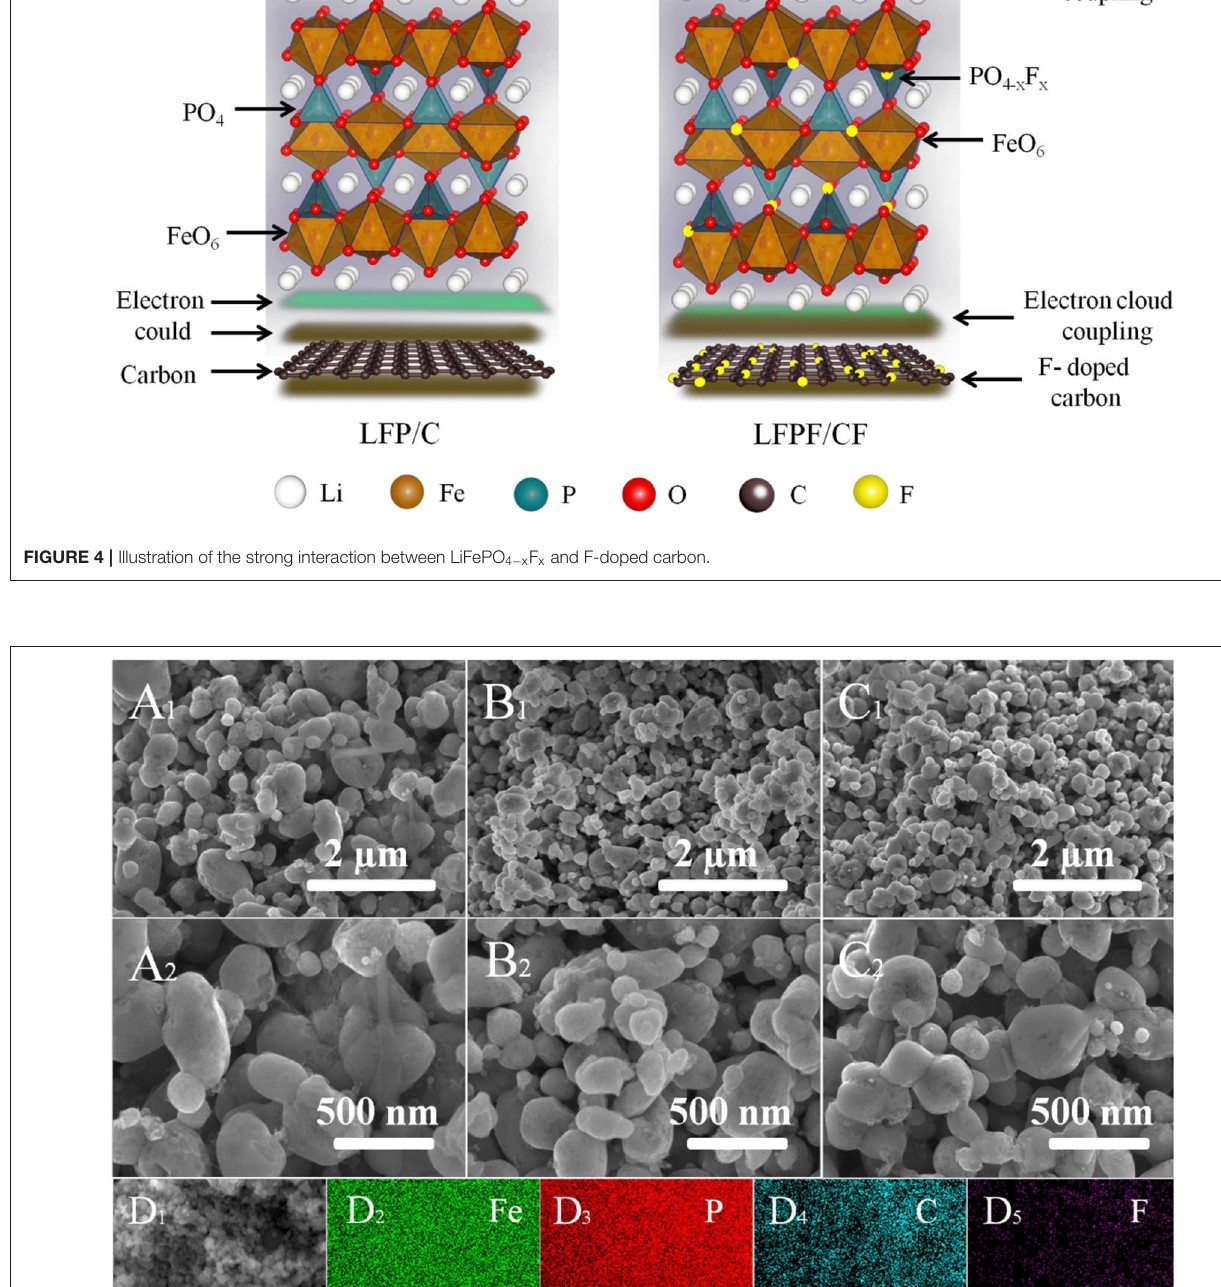
Frontiers in Materials |